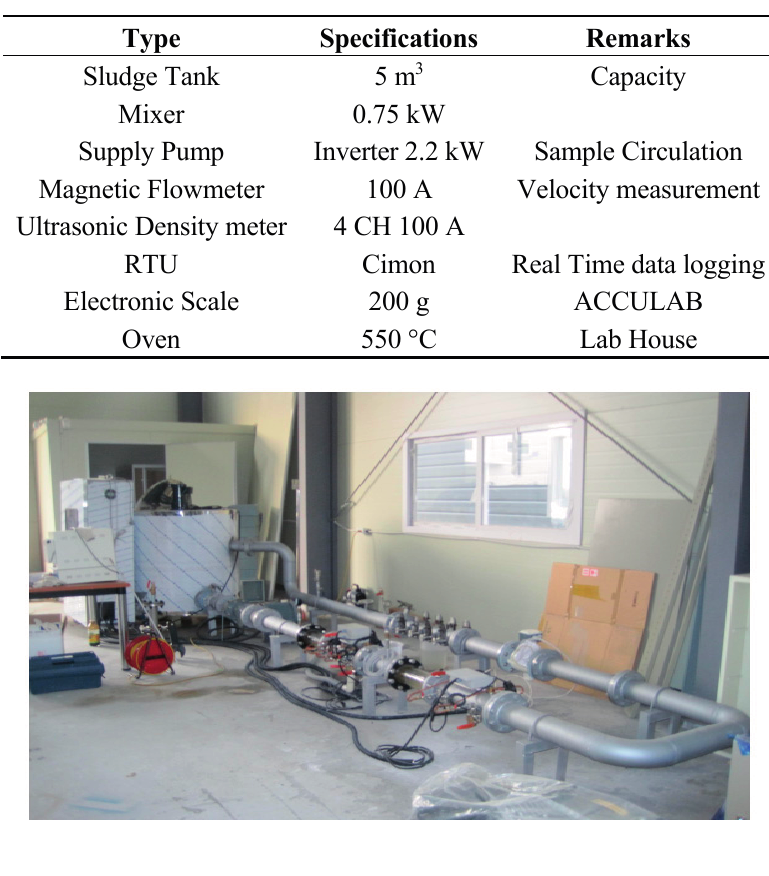
Figure 11. Pilot plant